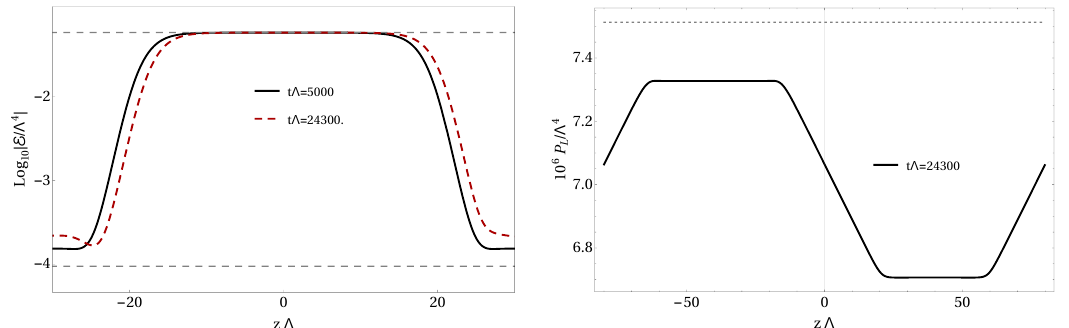
Figure 19 . Snapshots for the simulation of (cid:12)gure 16(right). (Left) Plot of the energy density at two very late times The top and bottom dashed, grey, horizontal lines correspond to E high and E low , respectively. (Right) Plot of the longitudinal pressure at a very late time. The dashed, grey, horizontal line is P c , the equilibrium pressure at T c